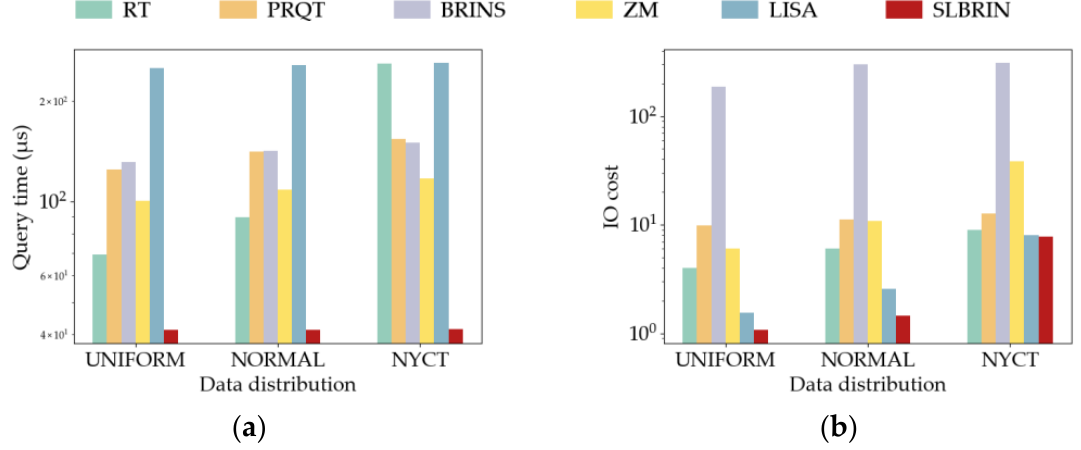
Figure 6. Point query performance vs. data distribution. ( a ) Query time. ( b ) IO cost.